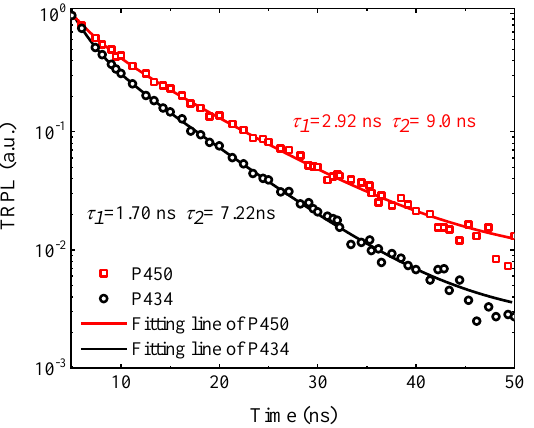
Figure 3. The TR-PL spectrum of the triangular-like ridge under excitation power P = 1.25 kW/cm 2 . As shown in Figure 3, the black and red solid lines are the fitting curves, and the lifetime of P450 is longer than that of P434, whatever for τ 1 or τ 2 . At the excitation power of P = 1.25 kW/cm 2 , we calculated that the τ 1 of P450 is 70% higher than that of P434, further confirming the different recombination mechanisms between P434 and P450. As